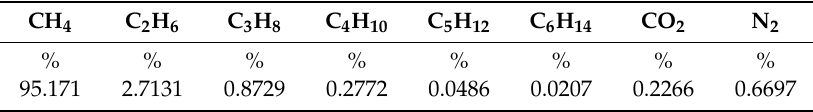
Table 2. Natural gas composition (Adapted from